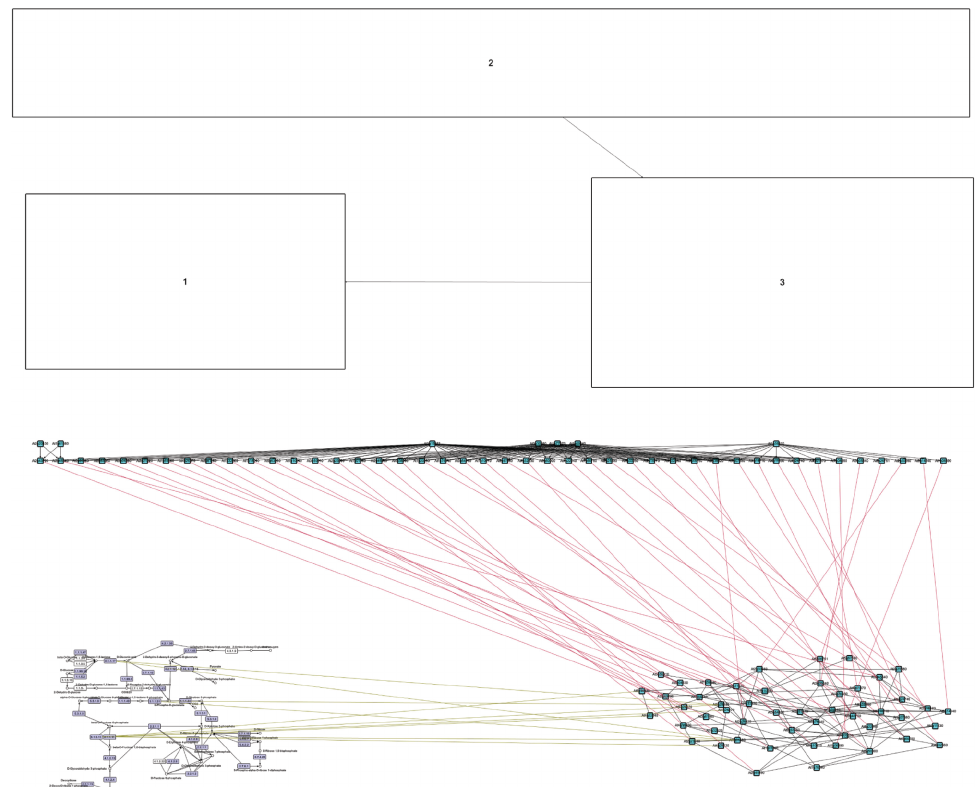
Figure 4: Overview graph (top) and clustered graph (bottom) for heterogeneous networks as an example. In contrast to previous figures where the size of nodes of the overview graph depends on the number of represented nodes, here the overview graph shows the bounding boxes of the layouts of the clustered